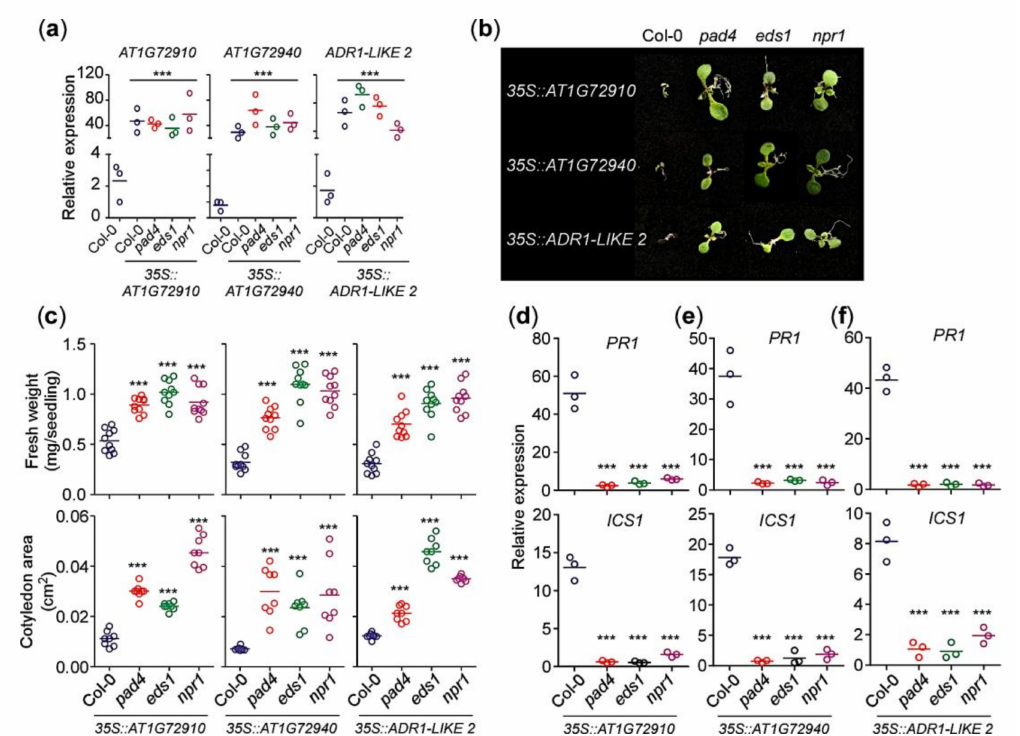
Figure 5. Overexpression of AT1G72910 , AT1G72940 , and ADR1-LIKE 2 results in autoimmunity in the WT background. ( a ) Validation of overexpression of AT1G72910 , AT1G72940 , and ADR1-LIKE 2 in transgenic lines in T 1 lines at 16 ◦ C. ( b ) Induction of a growth arrest phenotype by overexpression of AT1G72910, AT1G72940 , and ADR1-LIKE 2 in Col-0 plants at 16 ◦ C. Note that the growth arrest phenotype was not seen in the pad4 , eds , and npr1 backgrounds, although AT1G72910 , AT1G72940 , and ADR1-LIKE 2 were overexpressed. ( c ) Quantification of fresh weight (mg per seedling) and cotyledon area (cm 2 ) of the transgenic seedlings overexpressing AT1G72910 , AT1G72940 , or ADR2-LIKE 2 at 16 ◦ C in the Col-0, pad4 , eds , and npr1 backgrounds. ( d – f ) PR1 and ICS1 expression in transgenic seedlings overexpressing AT1G72910 ( d ), AT1G72940 ( e ) or ADR2-LIKE 2 ( f ) at 16 ◦ C in the Col-0, pad4 , eds , and npr1 backgrounds. All of the experiments were conducted at 16 ◦ C under long day conditions. Letters indicate significant di ff erence from one-way ANOVA followed by Tukey’s range tests ( p < 0.05) ***: p ≤